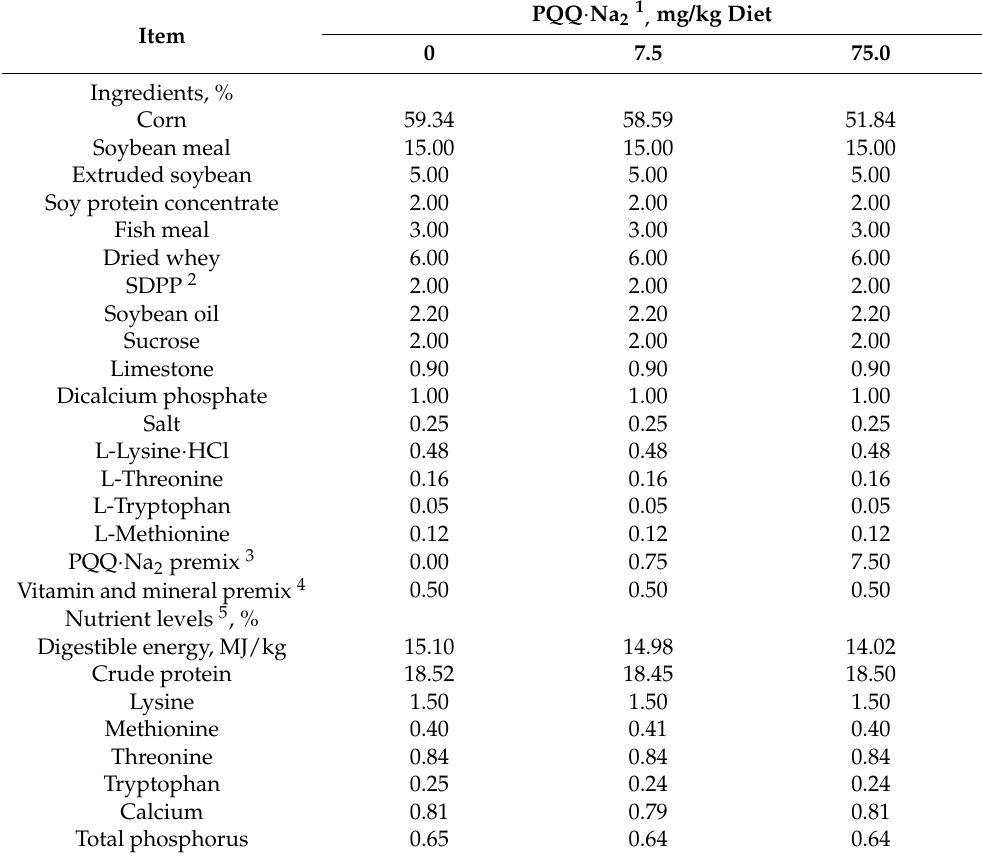
Table 1. Composition and analyzed nutrient composition of experimental diets (as-fed basis).